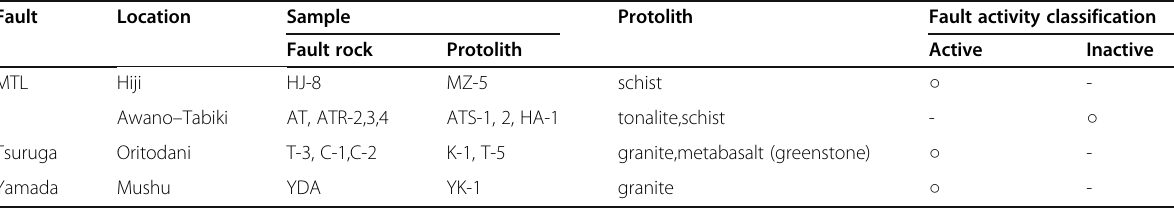
Table 1 Locations and fault/protolith details of the analyzed samples (see Figs. 1 and 2 for sample locations) Fault